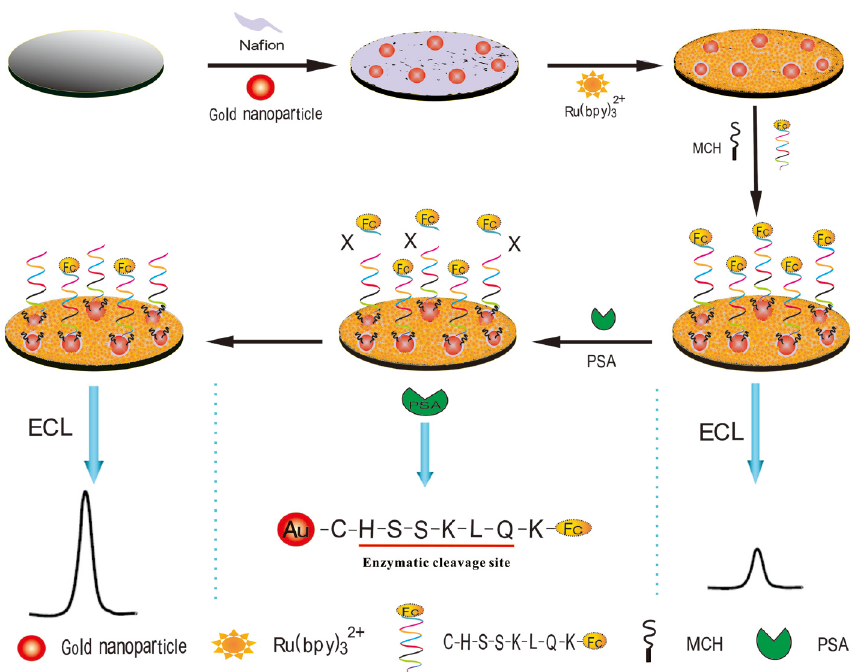
Figure 3 Schematic diagram of the fabrication process of ECL-PB biosensor for the determination of PSA. Reprinted with permission from Qi et al. (2014). © 2014 American Chemical